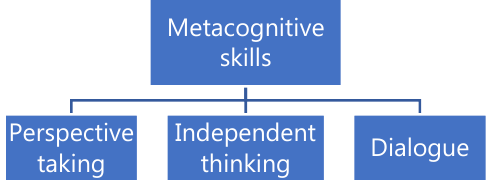
Figure 2. Main theme, metacognitive skills, and sub-categories.